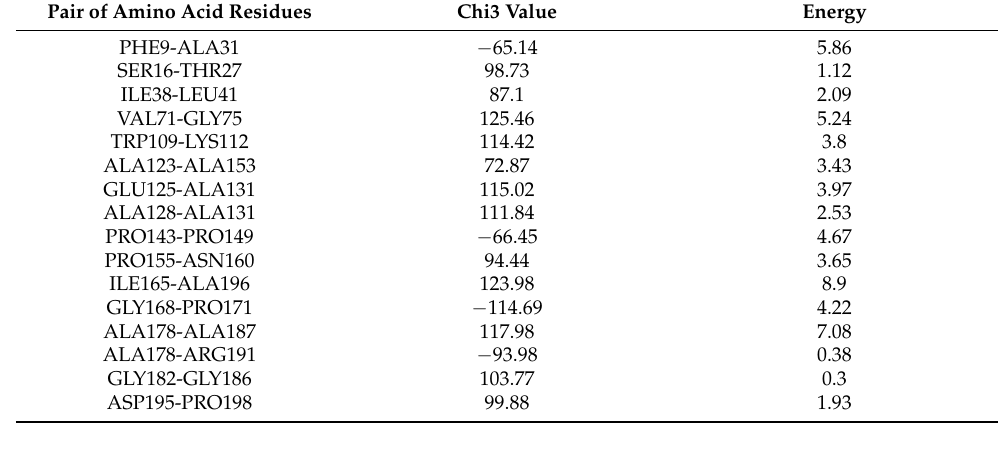
Table 5. Amino acid residues that are replaced by cysteine amino acid.